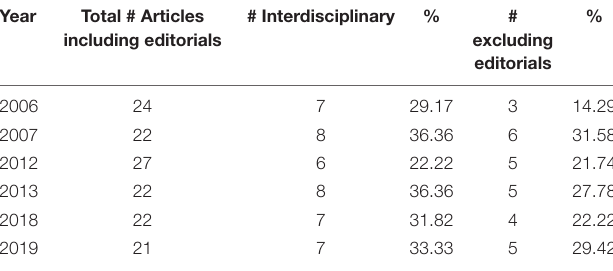
TABLE 7 | Interdisciplinary composition of ijCSCL multi-authored